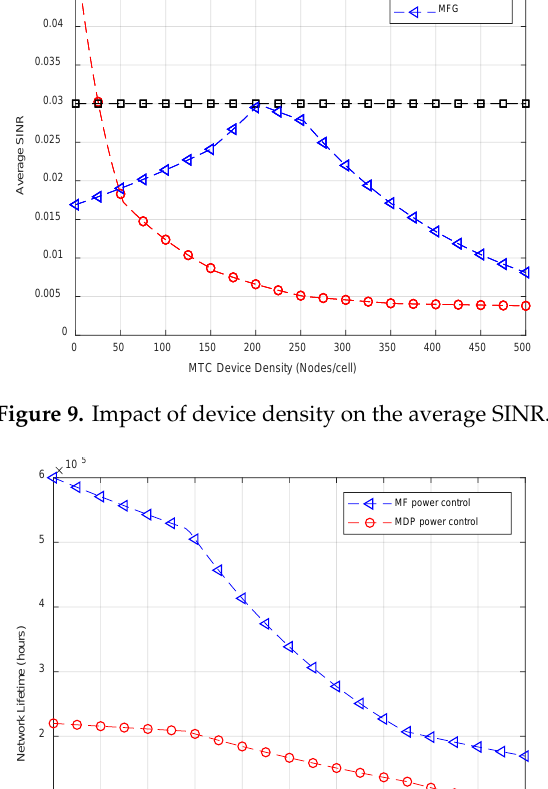
Figure 10. Target SINR impact on MTCDs network.